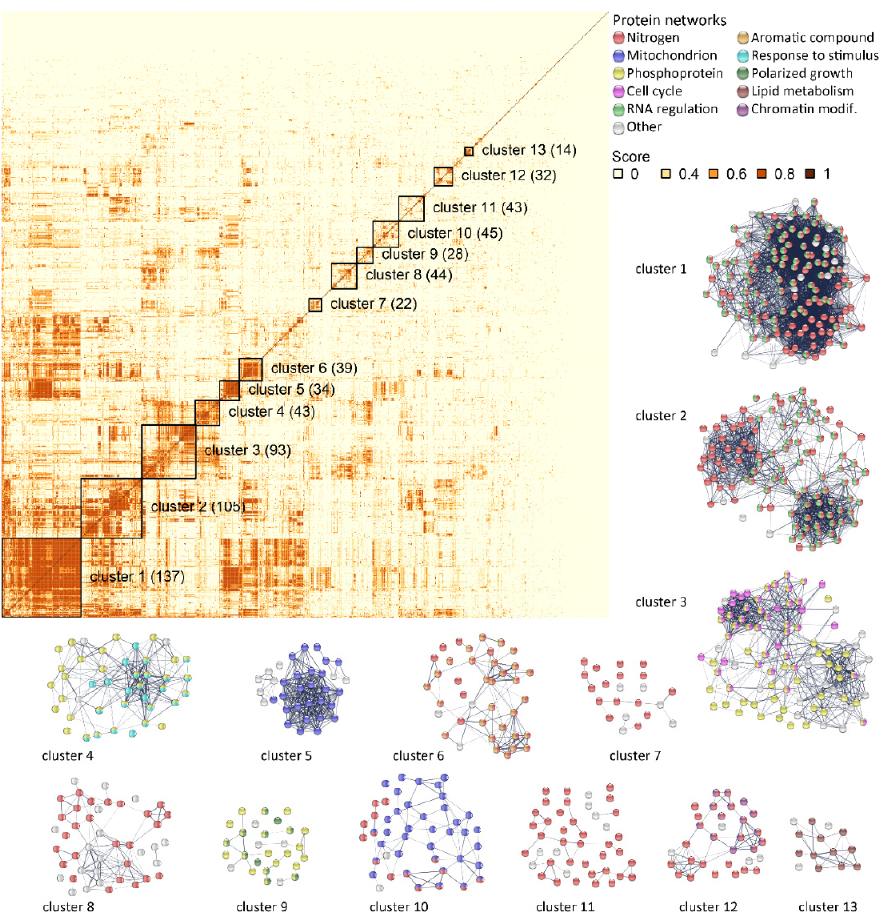
Figure 7. STRING protein–protein interaction analysis. Clustered pairwise correlation matrix (top left) of the 1124 differentially regulated genes in the Fx10- ∆ AE mutant. For each pair of genes, a protein– protein interaction (PPI) confidence score was extracted from STRINGdb (http://string-db.org/). A total of 13 clusters are visually defined (the number of proteins per cluster is shown in brackets), and the STRING PPI network connectivity is represented. For each cluster, the main functional enrichment(s) of the networks (biological process from gene ontology, local network cluster from STRING, or annotated keywords from UniProt) are represented by different colors.